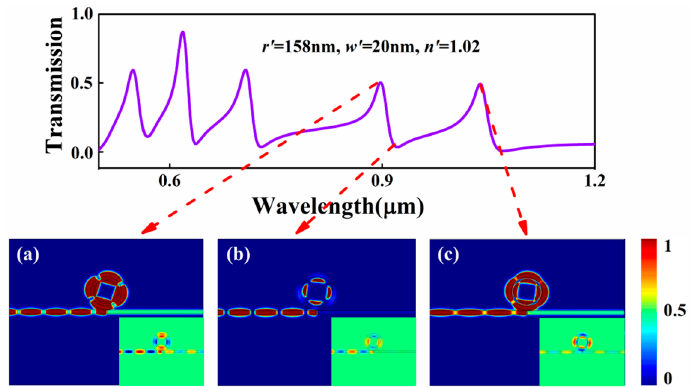
Figure 7. Transmission spectrum of the MIM waveguide with two concentric rings resonators when r ’ = 158 nm, w ’ = 20 nm, and n ’ = 1.02; the contour profiles of magnetic intensity distributions |H z | 2 of the device at ( a ) λ = 898 nm; ( b ) λ = 921 nm; ( c ) λ = 1035 nm. The insets denote the corresponding H z distribution of SPPs in the concentric rings system.